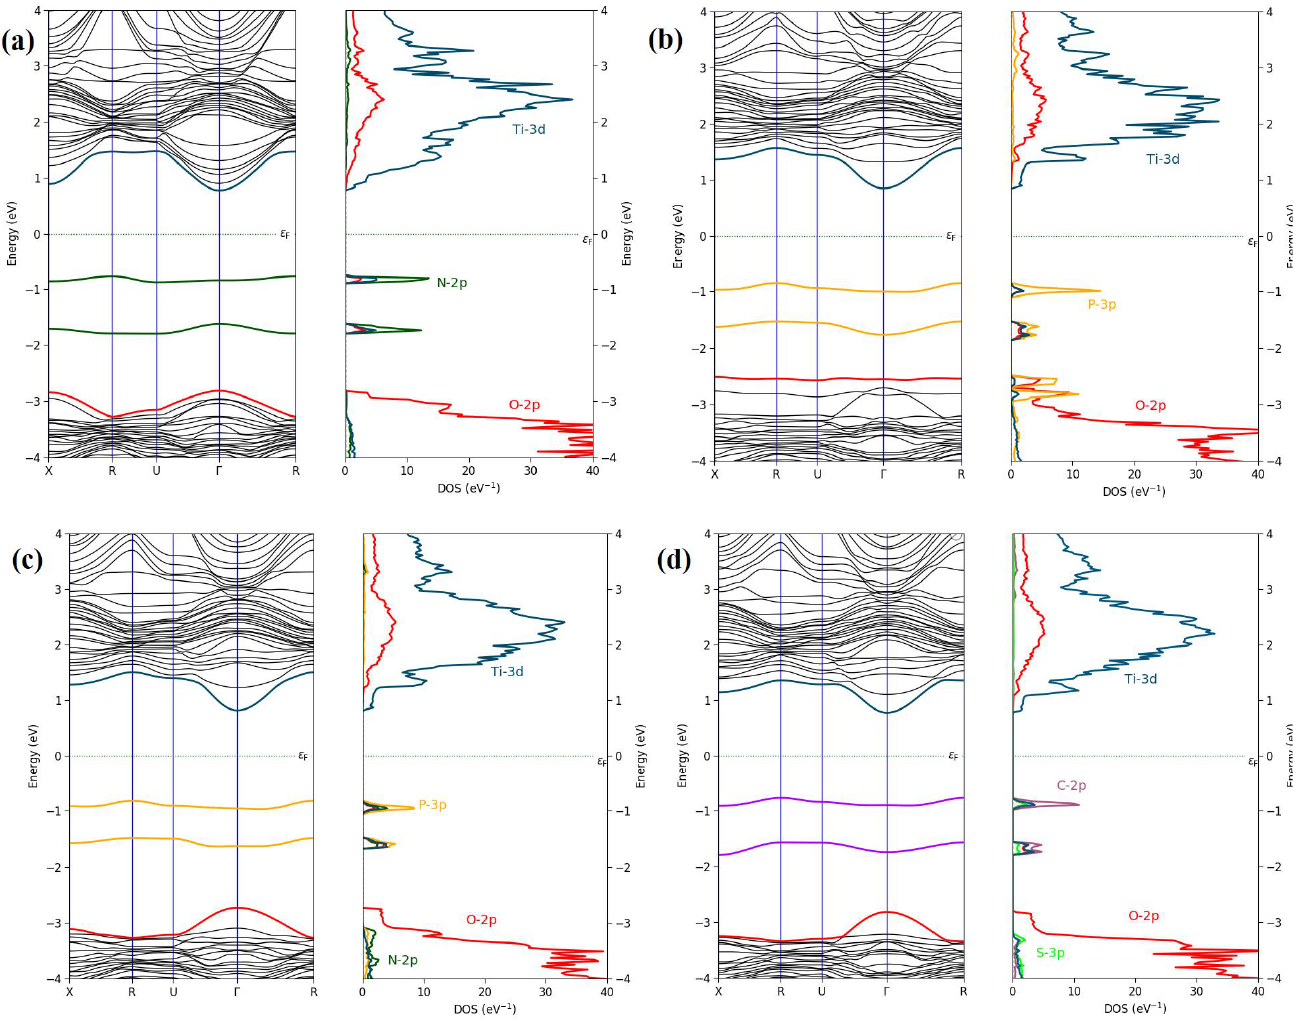
Figure 3. Electronic band structure and partial density of states for ( a ) N−N, ( b ) P−P, ( c ) N−P, and ( d ) C−S co-doped BaTiO 3 .